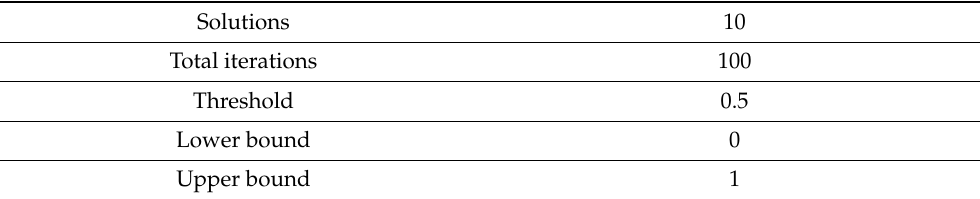
Table 1. Parameters of